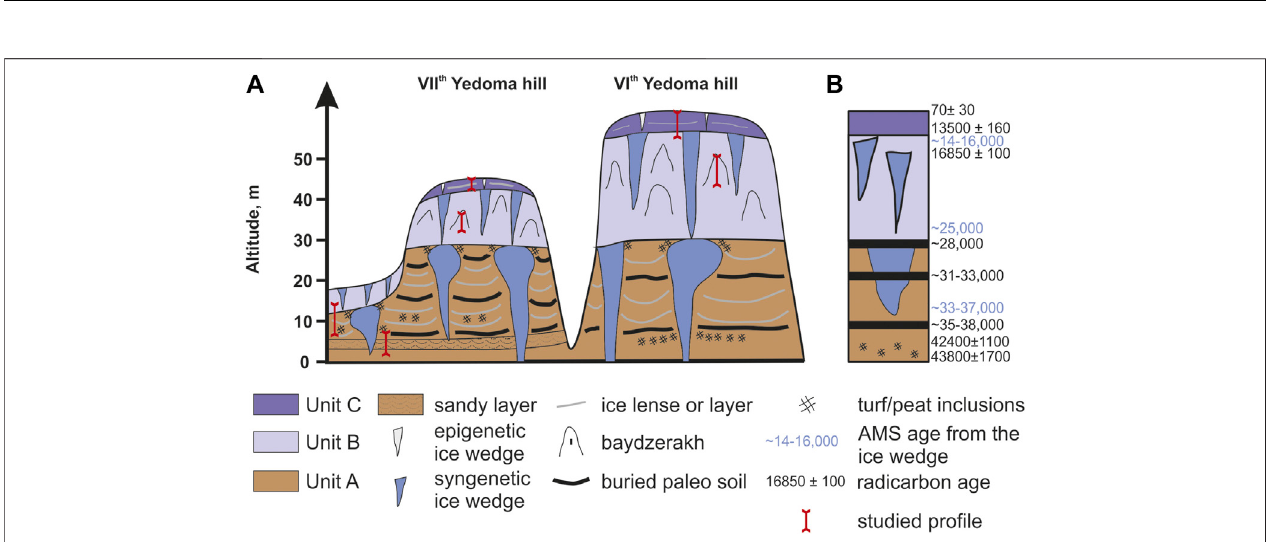
FIGURE 3 | Scheme of the Duvanny Yar exposure. The VI th and the VII th Yedoma hill correspond to previously described exposures (Sher et al., 1979). (A) – geological cross-section. (B) – review of Duvanny Yar deposit dating.